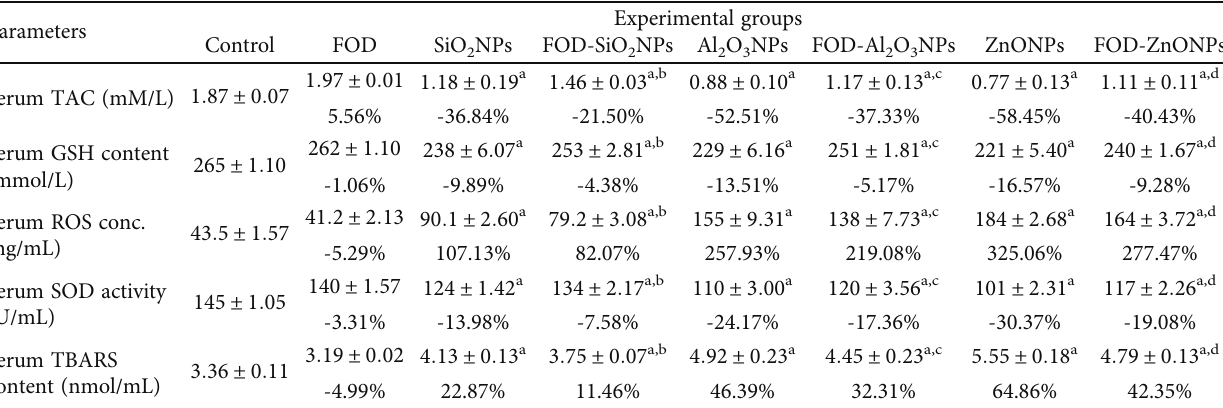
Table 1: The e ff ects of fi g with olive oil and date palm fruit extract on the serum oxidative stress markers of male rats treated with silicon oxide nanoparticles, aluminum oxide nanoparticles, or zinc oxide nanoparticles for 75 days.